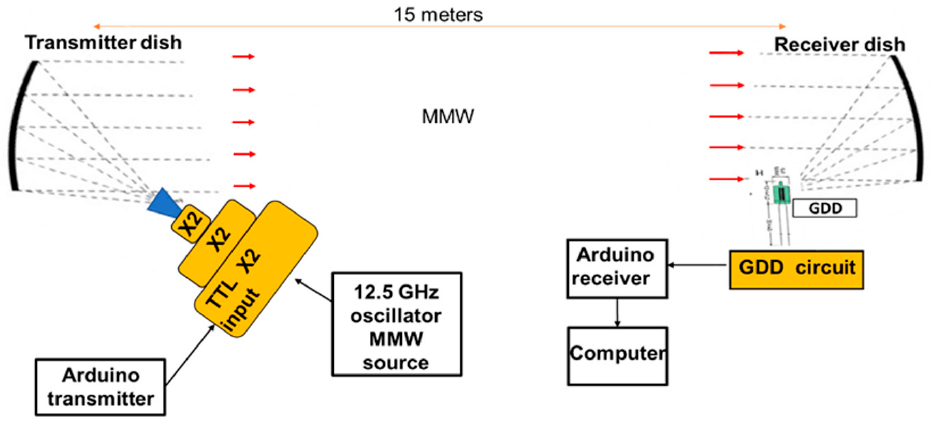
Figure 1. Block diagram of the experimental setup of MMW projection